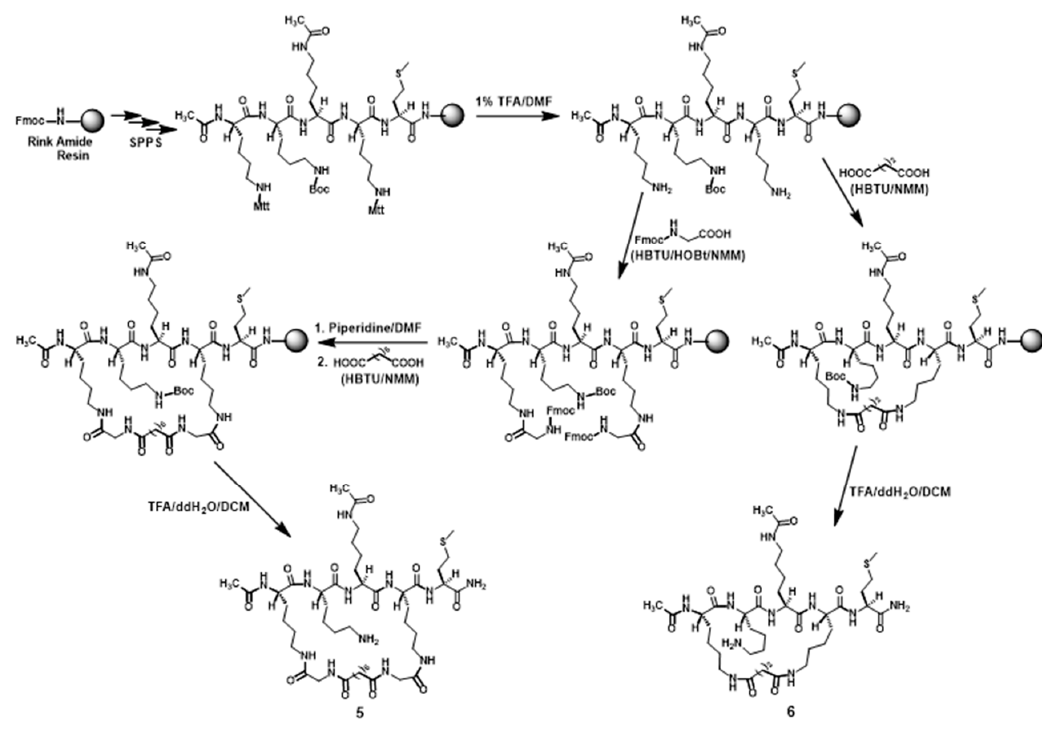
Scheme 1. The synthetic scheme of compounds 5 and 6. Table 1. The high-resolution mass spectrometry (HRMS) analysis of the purified compounds 5–8 a . Compound Ionic Formula Calculated m / z Observed m /